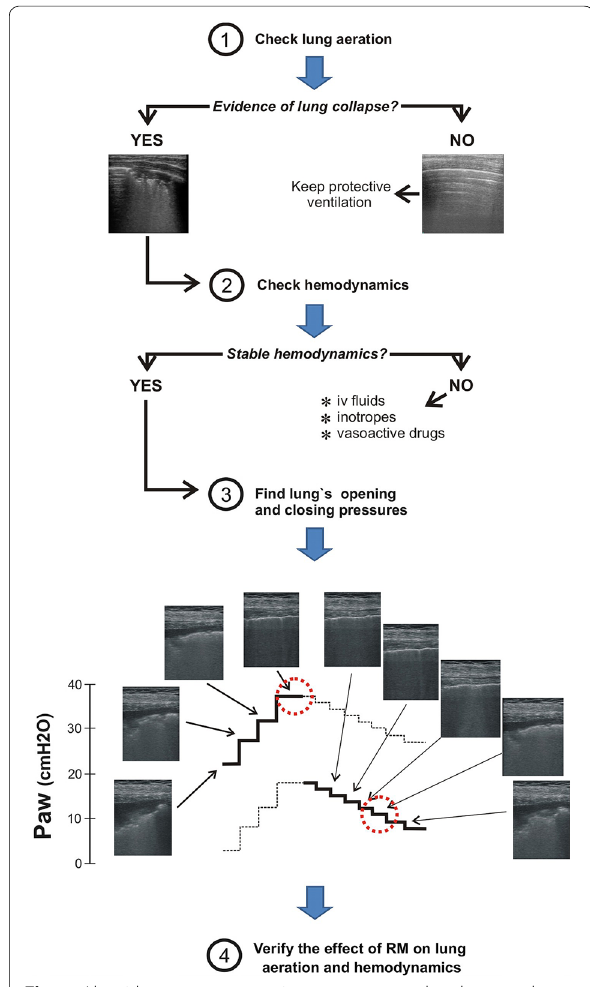
Fig. 1 Algorithm to assess recruitment maneuver by ultrasound. Ultrasound diagnoses lung collapse (step 1) and assesses hemody- namics (step 2) before the lung recruitment maneuver is done (step 3). During the step-wise increment in airways pressure (Paw) of the recruitment maneuver, ultrasound can detect the plateau pressure at which dependent lungs collapse disappear (opening pressure— upper circle ). Then, ultrasound defines the start of lung re-collapse in the most dependent pulmonary areas during the PEEP trial (closing pressure— lower circle ). The images were obtained in an anesthetized child using a linear 7–13 MHz probe placed in the oblique position